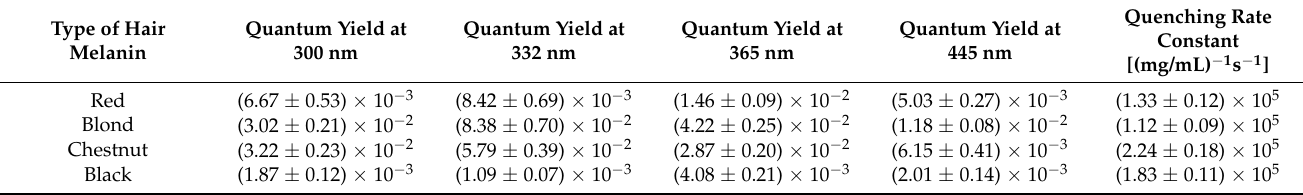
Figure 10. Determination of quantum yield of singlet oxygen photogeneration by melanin nanoaggregates from different hair at: 300 nm laser excitation (A), 332 nm laser excitation (B), 365 nm laser excitation (C), and 445 nm laser excitation (D). Color lines indicate the following samples: orange (red hair), yellow (blond hair), brown (chestnut hair), and black (black hair). Magenta in A, B, and D represents fluorescein as a reference sample, whereas magenta in C represents proflavine used as a standard. Table 1. Quantum yields of singlet oxygen photogeneration at different wavelengths for melanin nanoaggregates from different hair and their quenching rate constants. Data represent mean ± S.D.